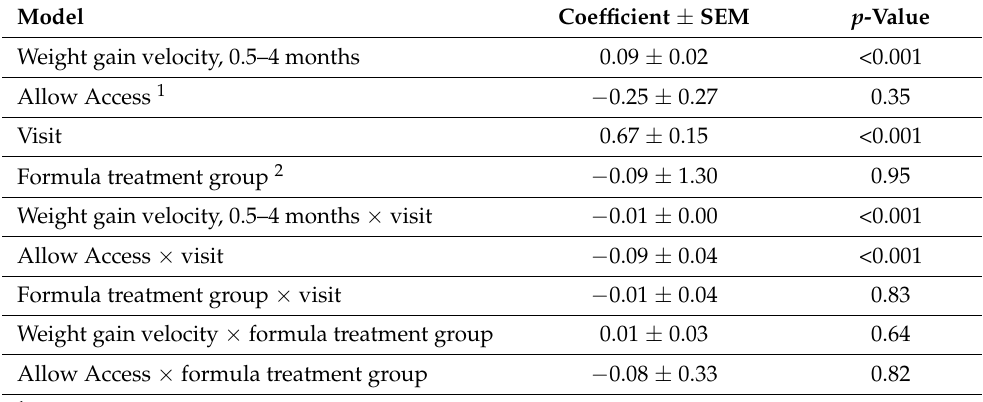
Table 4. Generalized linear mixed models on trajectory of WLZ score from 1 year to 1.5